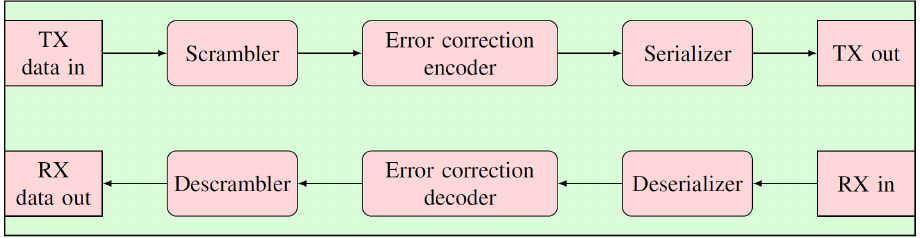
Figure 2. Diagram of the overall communication